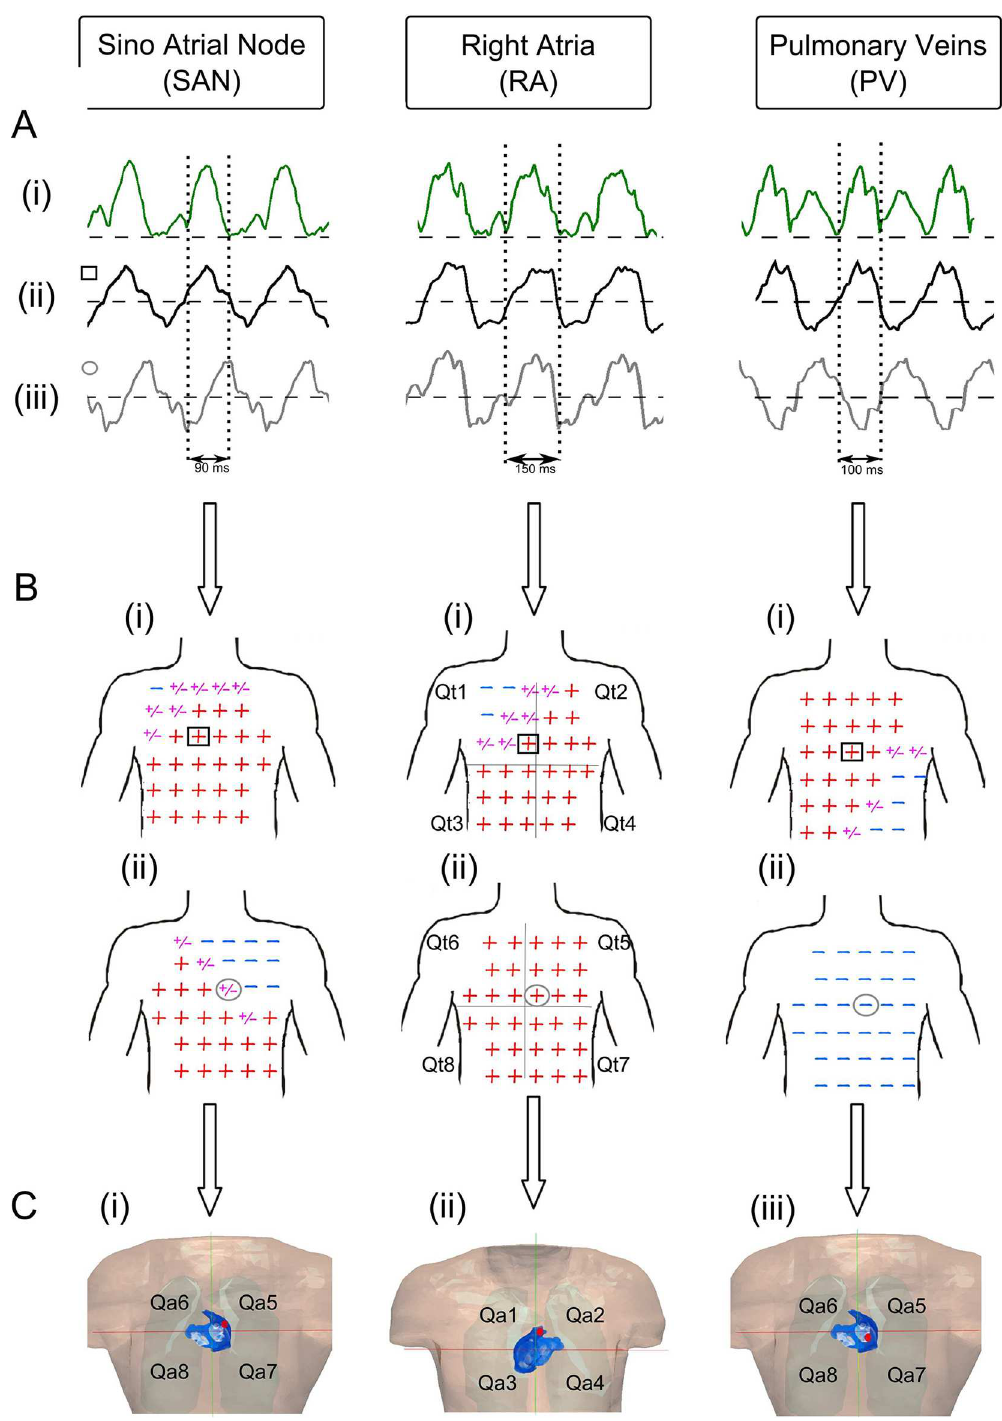
Fig 4. Illustration of the correlation used by the algorithm for activation from three atrial sites. (A): Dipole sum (green line) (i), lead V1 (black line) (ii) and Lead 47 (Grey line)(iii),(i) were used to identify the time interval (section betweendotted lines) of re-entrant patterns where the tip was locatedin the sino-atrialnode (SAN), right atria (RA) and pulmonary veins (PV). The amplitudein all cases has been normalized. (B): Atrial-wave polarity map in the anterior (i) and posterior (ii) part of the torso for atrial activationinitiatedat different locationsof the atria (SAN, RA and PV). A red sign represents a positive polarity in the atrial-wave, the blue sign is a negativepolarity and a purplesign representsa biphasicatrial-wave. The black squarerepresents the electrodepositionof lead V1,